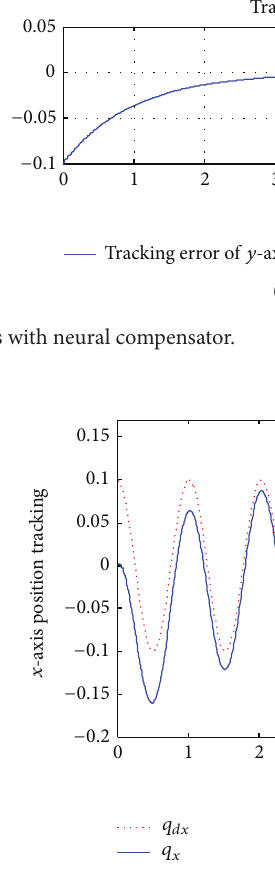
Figure 13: 𝑥 -axis position tracking with neural